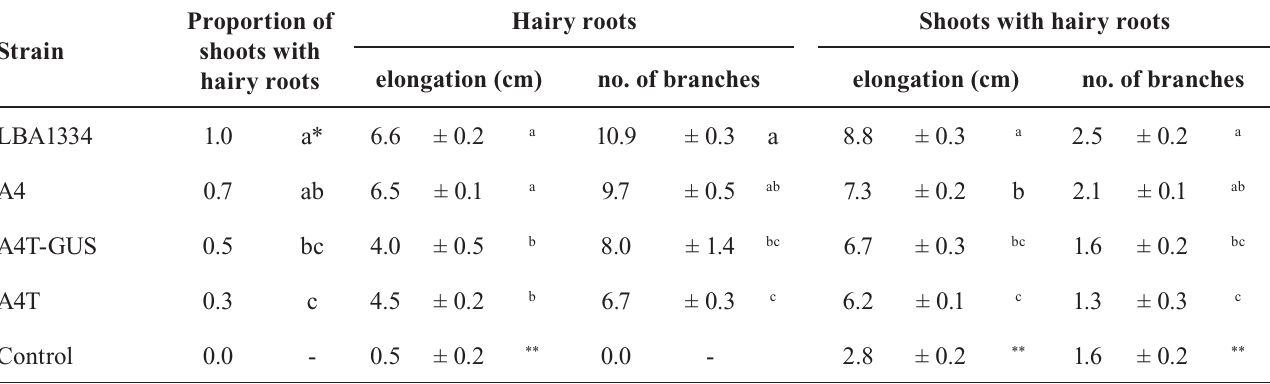
TABLE II - Efficiency of hairy root development by shoots inoculated in Rockwool cubes, and the performance of hairy roots and responding shoots after three-week culture (mean values with standard errors)